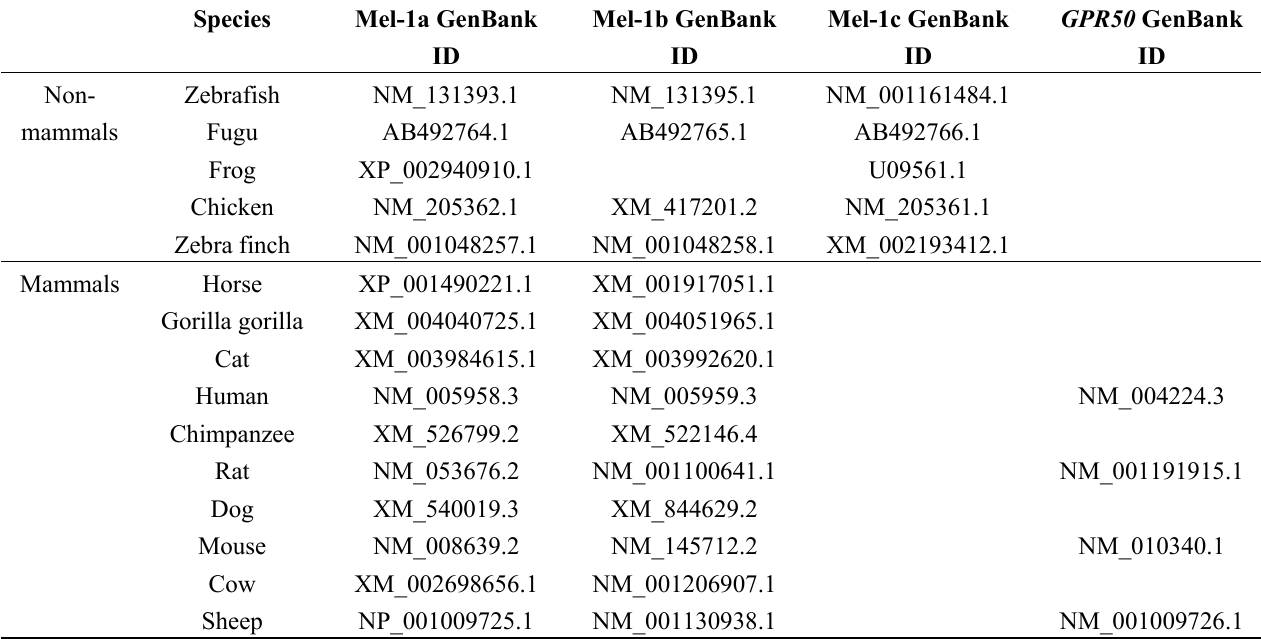
Table 2. GenBank accession numbers of melatonin receptor and GPR50